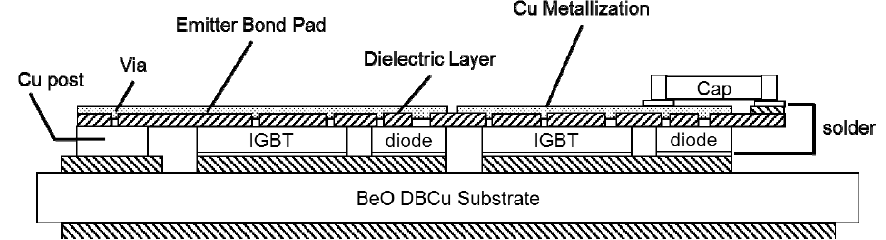
Figure 8. A schematic showing the cross section of the General Electric (GE) power overlay technique